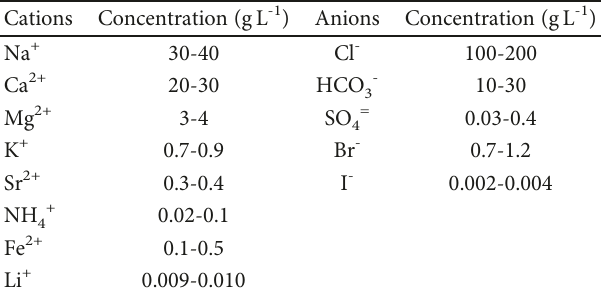
Table 1: Reported range of compositions of groundwater brines in the Precambrian basement in the centre of the Baltic Synclinorium in Western Lithuania